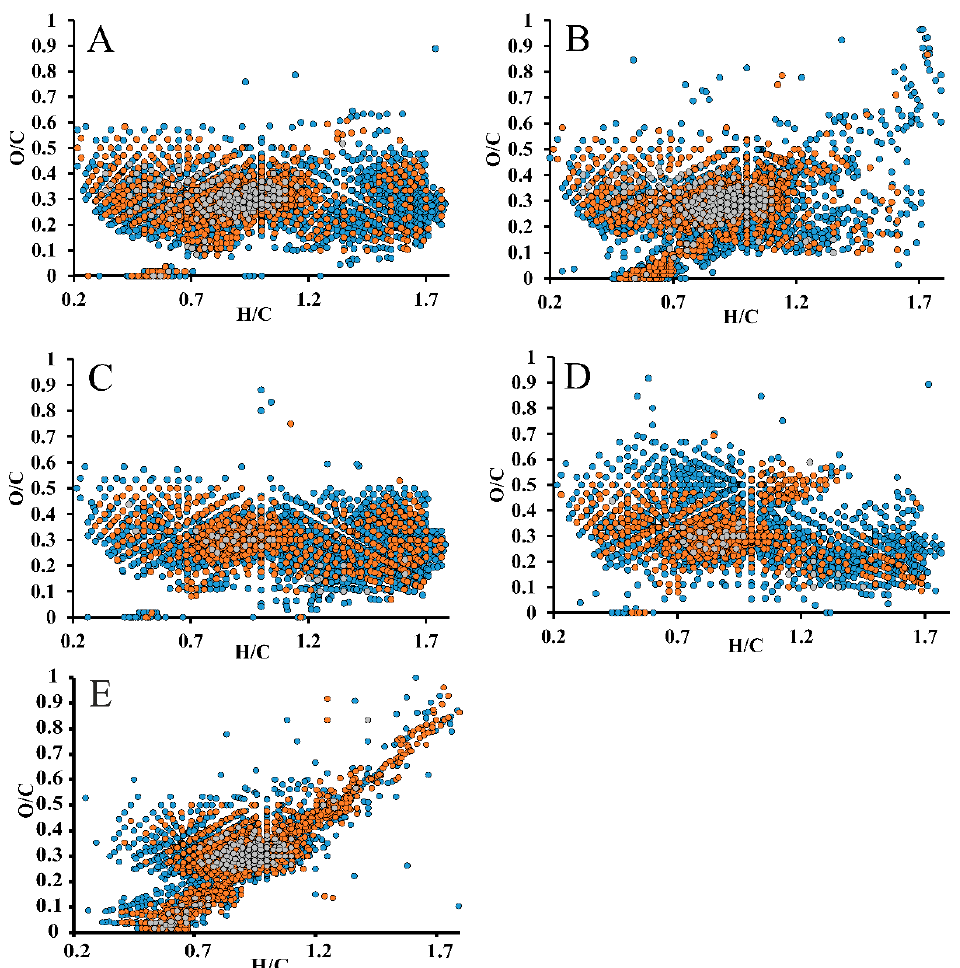
Figure 4. Van Krevelen plots for IL lignin preparations obtained using [bmim]OAc ( A ), [bmim]OAc-DMSO ( B ), [bmim]MeSO 4 ( C ), [bmim]MeSO 4 -DMSO ( D ) and dioxane lignin ( E ). Dot colors designate the relative intensities of corresponding peaks in mass spectra: 0.1–1% (blue), 1–10% (brown), >10% (grey).